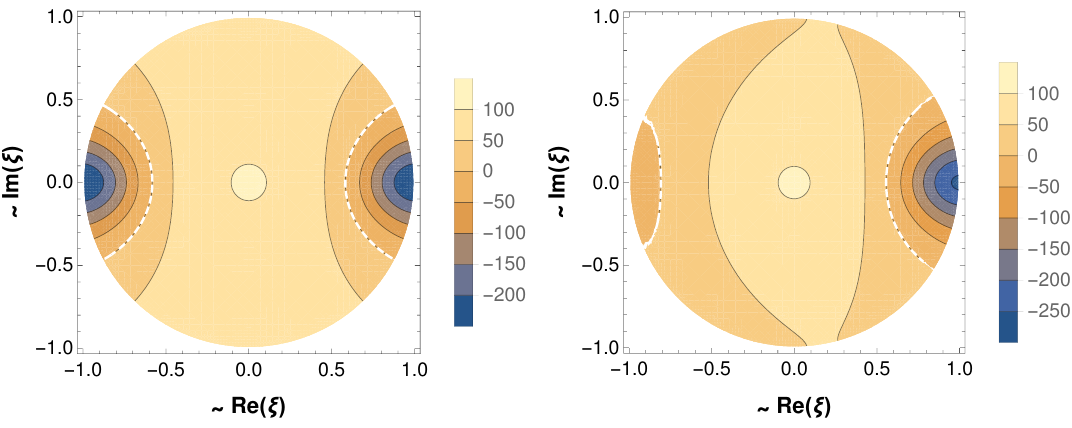
Figure 5. Contour plots of ~ g yy with ( a = 1 ; R y = 1 ; (cid:18) = 0 ; c = 100) for speci(cid:12)ed F ( (cid:24) ). Plotted on the unit disc j (cid:24) j (cid:20) 1 with radial direction rescaled to tan r . The boundaries between positive and negative domains (~ g yy = 0) are separated by a dashed white